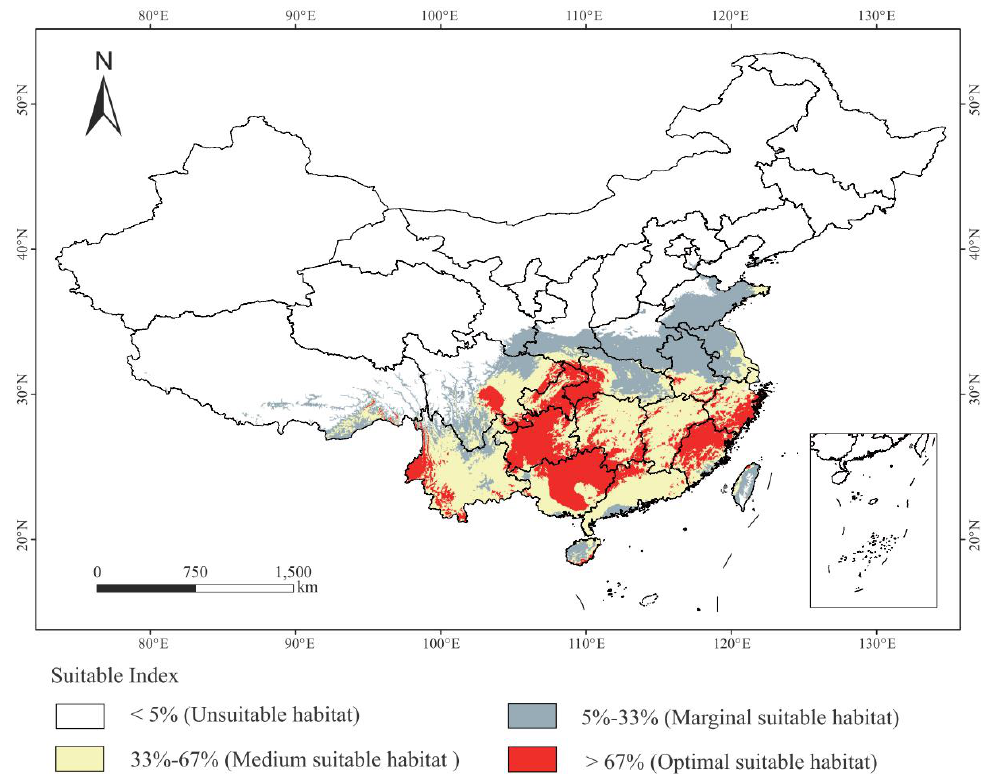
Figure 5. The potential distribution area of tea based on the current bioclimatic variables and occurrence records.